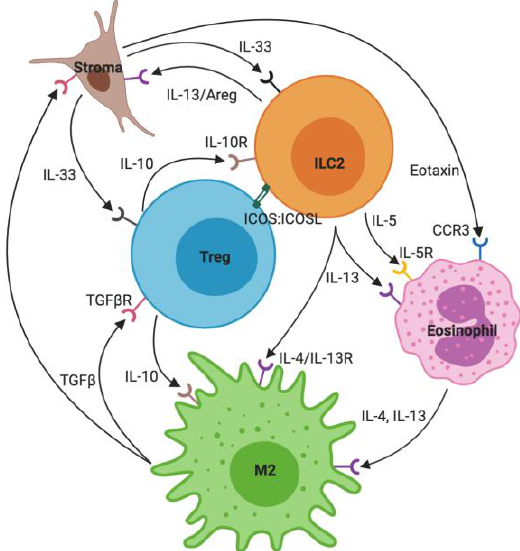
Figure 1. Key Group 2 innate lymphoid cells (ILC2) interactions. ILC2s are activated by the IL-33 released from stromal cells and produce mainly IL-5 and IL-13. These cytokines maintain eosinophils, which, together with ILC2s, in turn maintain an M2 macrophage phenotype. M2 macrophages release transforming growth factor beta (TGF β ), which both acts on stromal cells as well as Tregs. Tregs control a type-2 environment through IL-10 and inducible T-cell co-stimulator (ICOS) signaling.